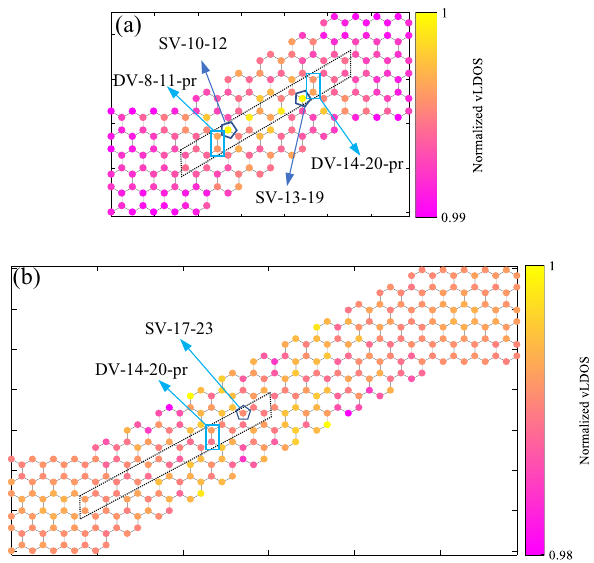
34.43 Å , and ( b ) L D 59.03 Å. Vacancies that ≈ ≈